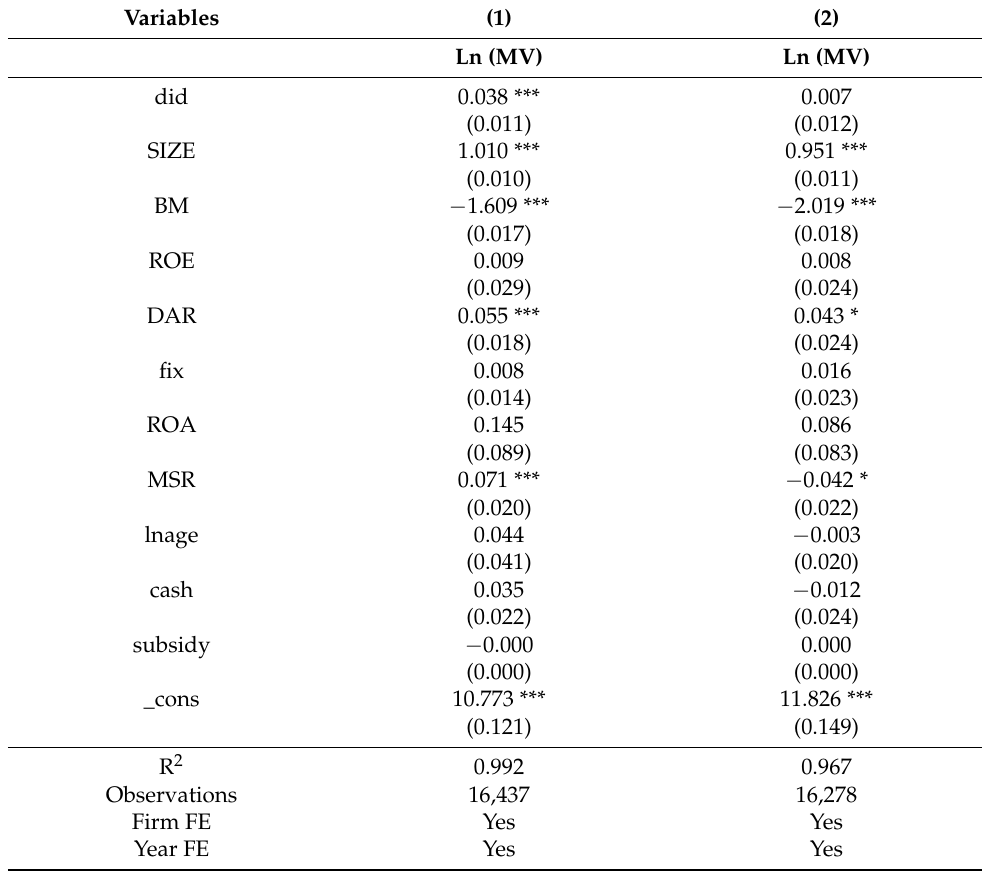
Table 13. Heterogeneous analysis of financial